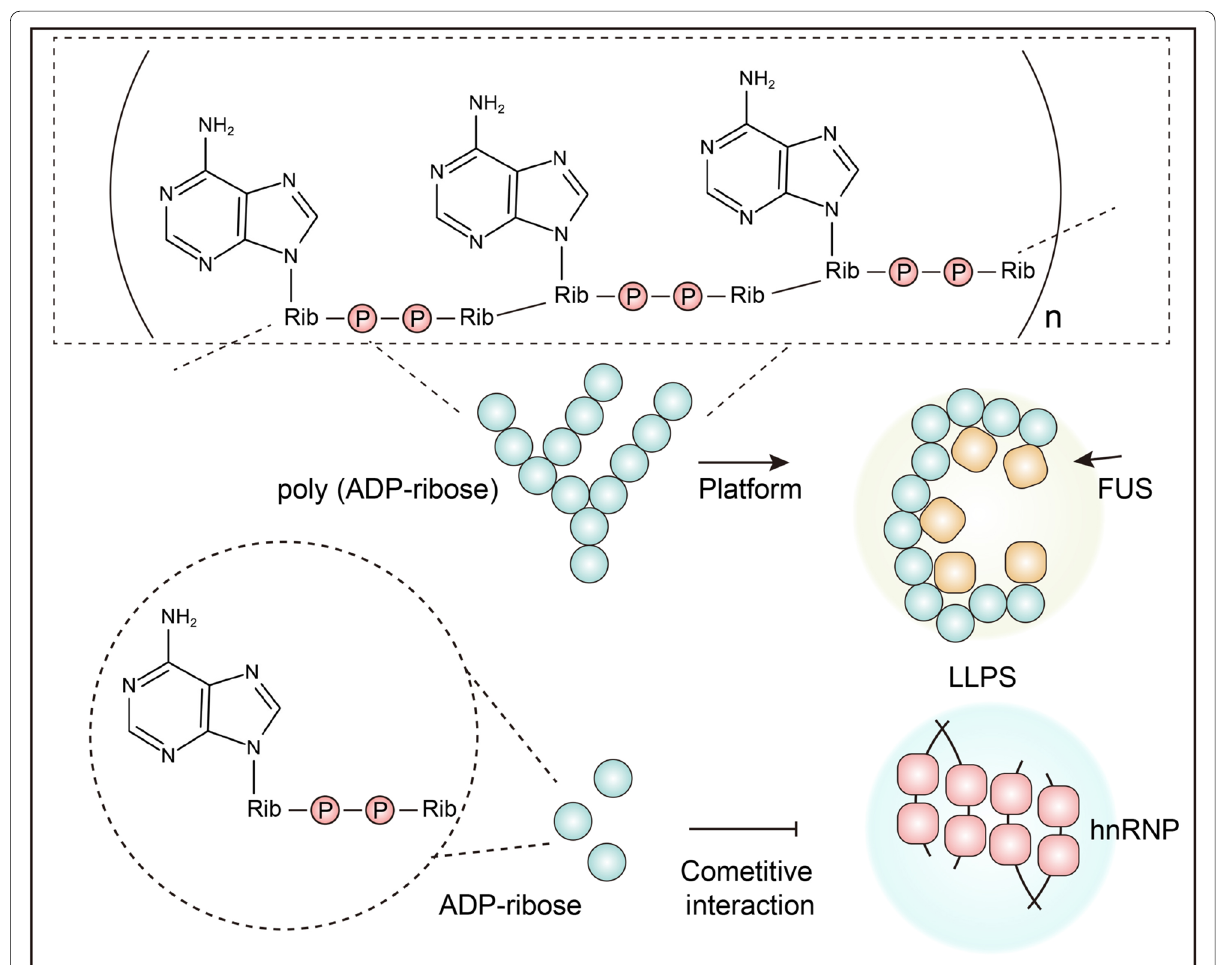
Fig. 7 Poly ADP-ribosylation promotes LLPS. ADP-ribose is able to interact with or modify on substrates. Mono ADP-ribose modification on PAR-binding motif impedes hnRNP LLPS by competitive interaction. On the contrary, poly (ADP-ribose) chain provides an ideal platform for multivalent interaction and promotes the LLPS of